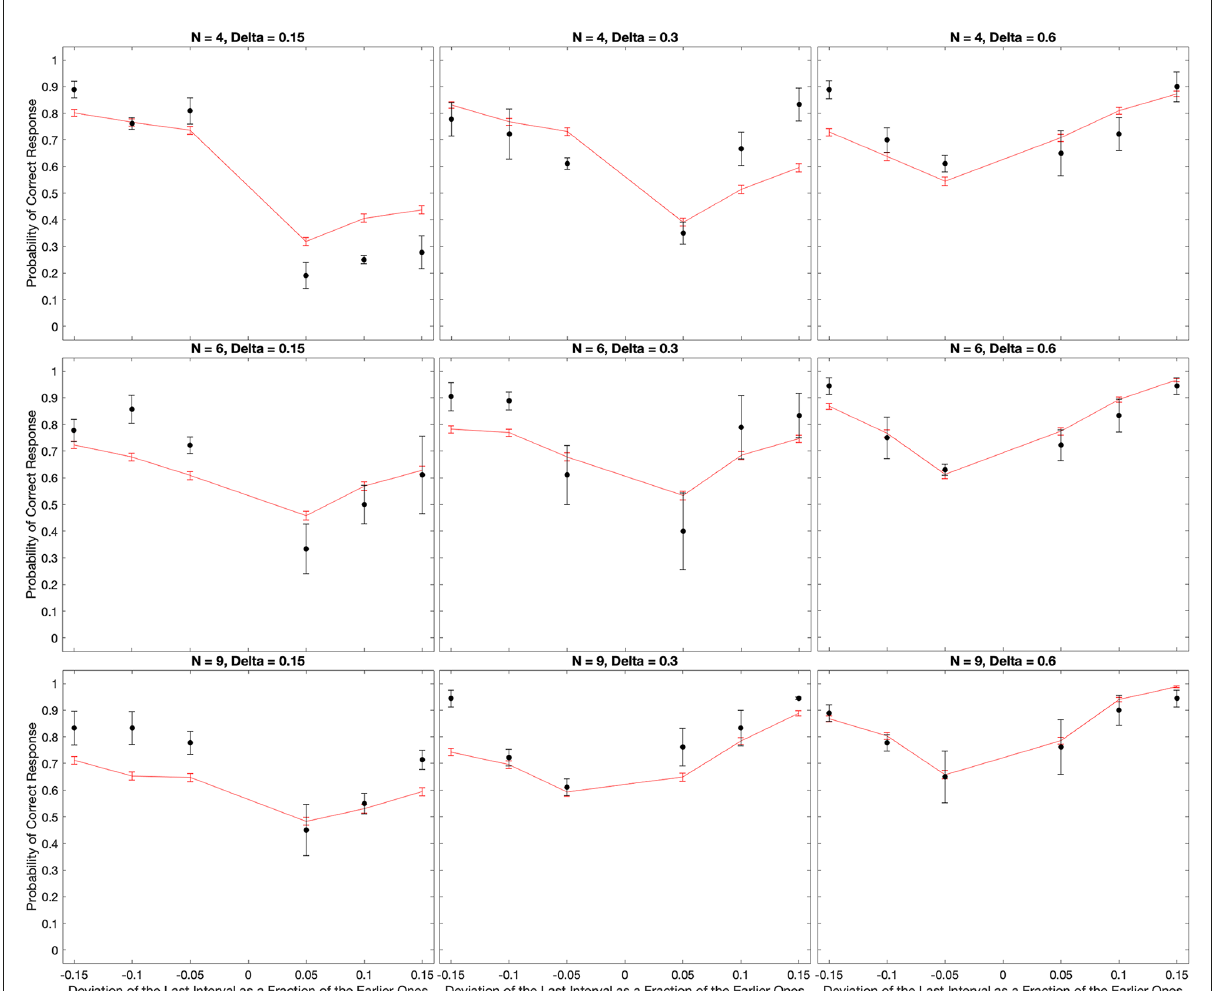
FIGURE7 Fits of the model to the median of the data across all subjects. The black dots show the experimental data and their standard errors. In turn, the red lines indicate the behavior of the model with optimal parameters and the absolute-value loss function (Equation 14). With few exceptions, the fits of the model capture well the behavior of the data both quantitatively and